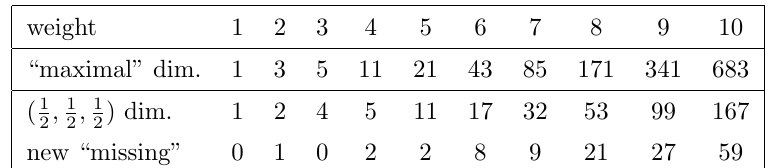
Table 20 . Dimensions of H hex when restricted to the 4 th root of unity point ( 1 up to 10. The \maximal" dimension is de(cid:12)ned in the